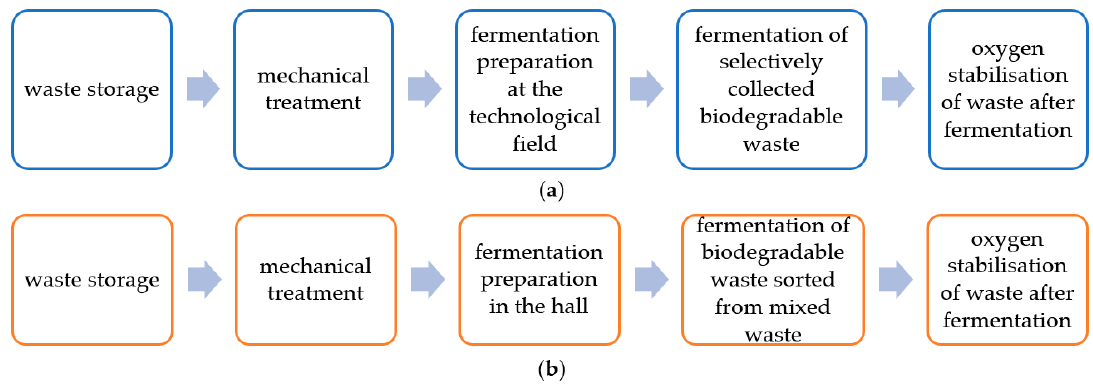
Figure 1. Process flow-chart of mechanical-biological treatment of waste at the analysed plant and main odour sources included in the research: A ( a ) and B ( b ).